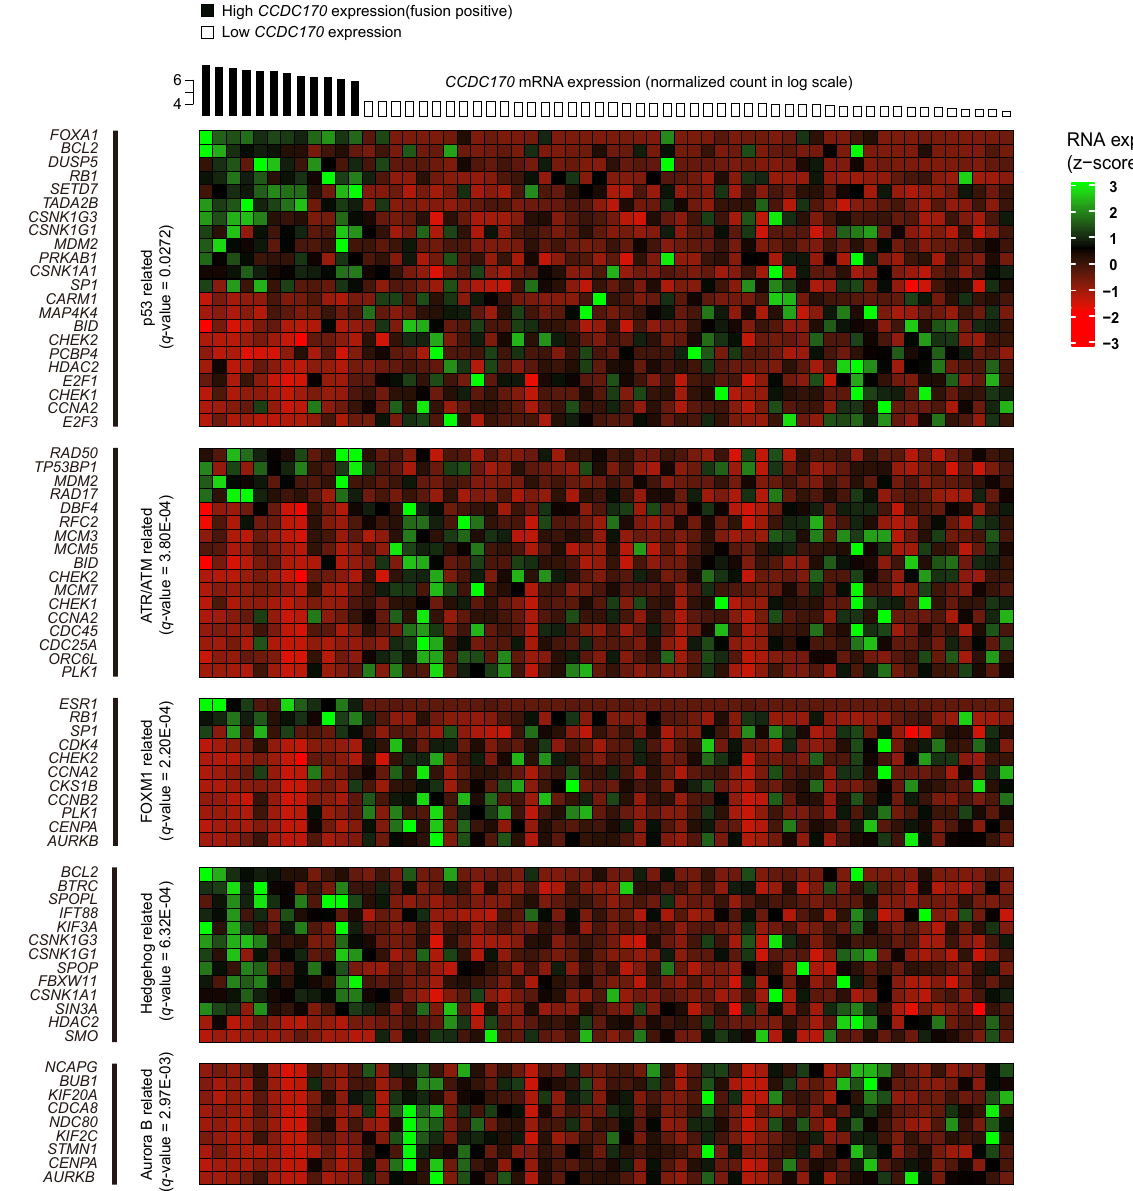
Figure 2. Gene expression heatmap of cancer-related pathways correlated with CCDC170 RNA expression. Of the analyzed genes, 72 of the genes associated with P53, ATR/ATM, FOXM1, hedgehog, and Aurora B demonstrated significant differences in expression in CCDC170 fusion-positive BRCA samples when compared with the control group. Over-representation analysis using ConsensusPathDB (CPDB) yielded statistically significant pathways related to cancer ( q < 0.05). The x -axis is indicative of the sample, while the y -axis is indicative of its respective RNA expression. The RNA expression was converted into z-score prior to representation on the